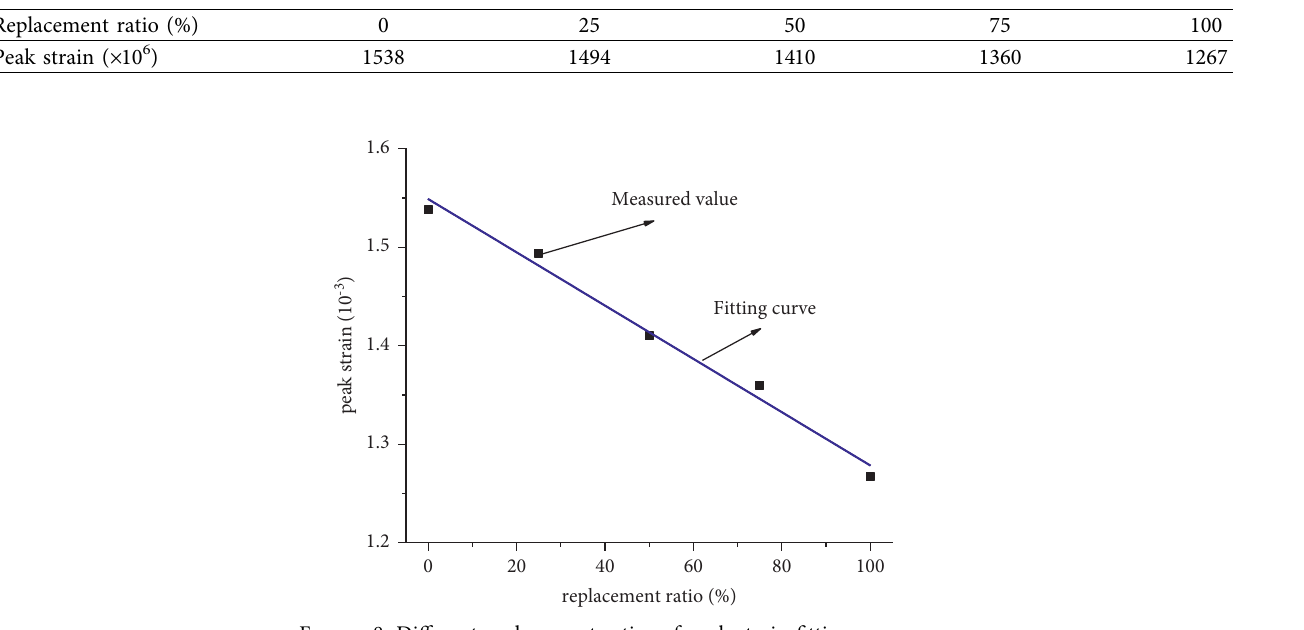
Table 3: Peak strain of recycled lightweight aggregate concrete.